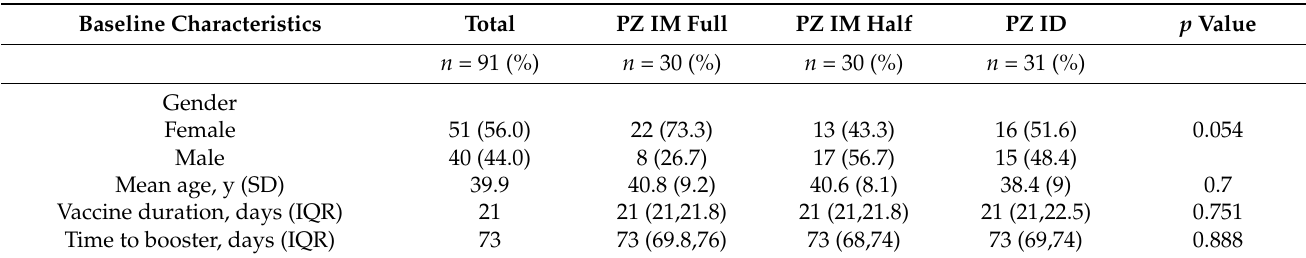
Table 1. Baseline characteristic of the intramuscular (IM) and intradermal (ID) BNT162b2 (PZ) mRNA vaccine booster in general population.